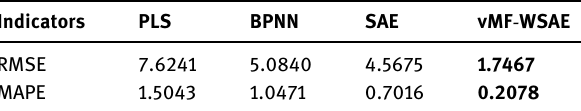
Bold represent the relative optimal value under this indicator in the comparison algorithm.